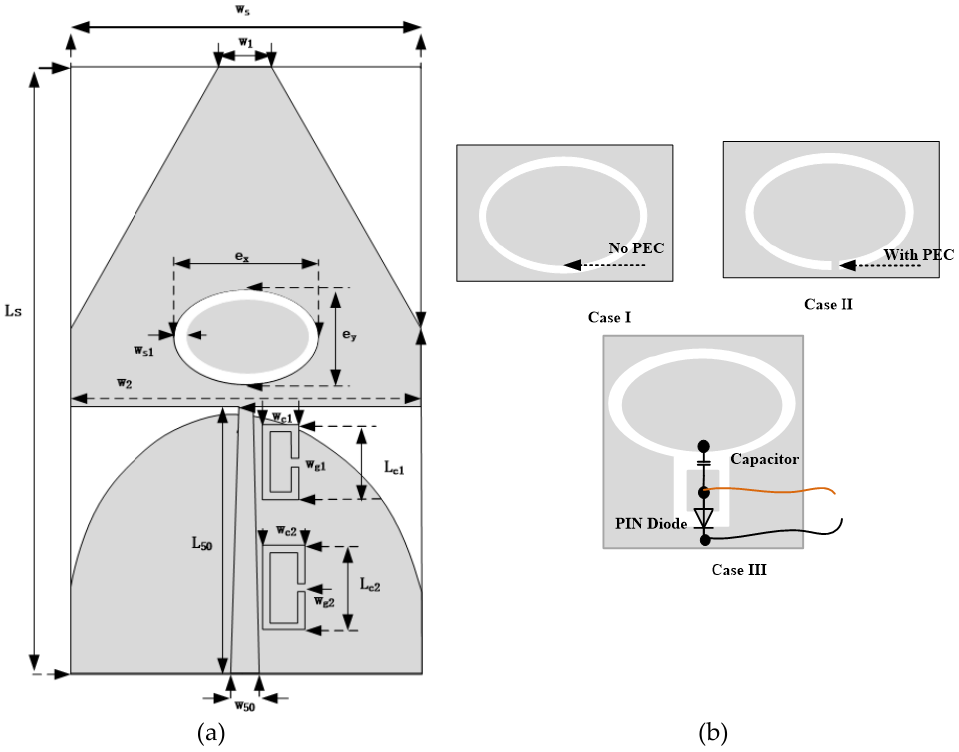
Figure 3. The schematic diagram of: ( a ) notch characteristics of a SWB antenna; ( b ) different cases of elliptical slots.